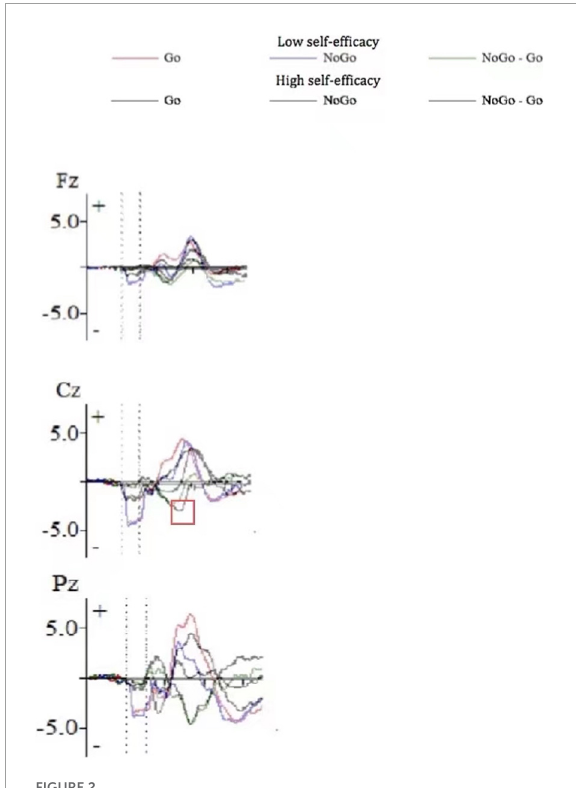
FIGURE2 The ERP waveform diagram of Fz, Cz, and Pz for the difference between high self-efficacy group and low self-efficacy group. FIGURE3